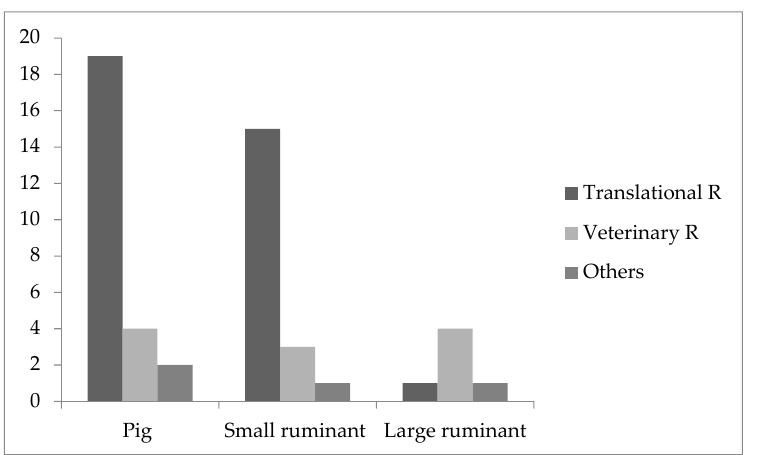
Figure 1. Medical research. The figure shows the specific use of farm animals in the field of biomed- ical research. The comments of participants indicated that “others” may include education and training